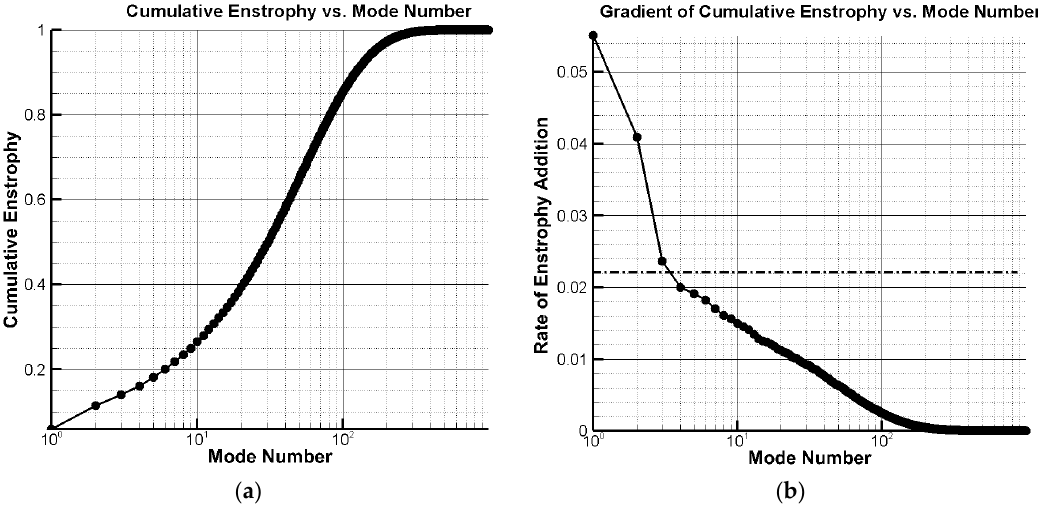
Figure 10. Modal enstrophy content for R1 region. ( a ) Cumulative modal enstrophy. ( b ) Rate of enstrophy addition.